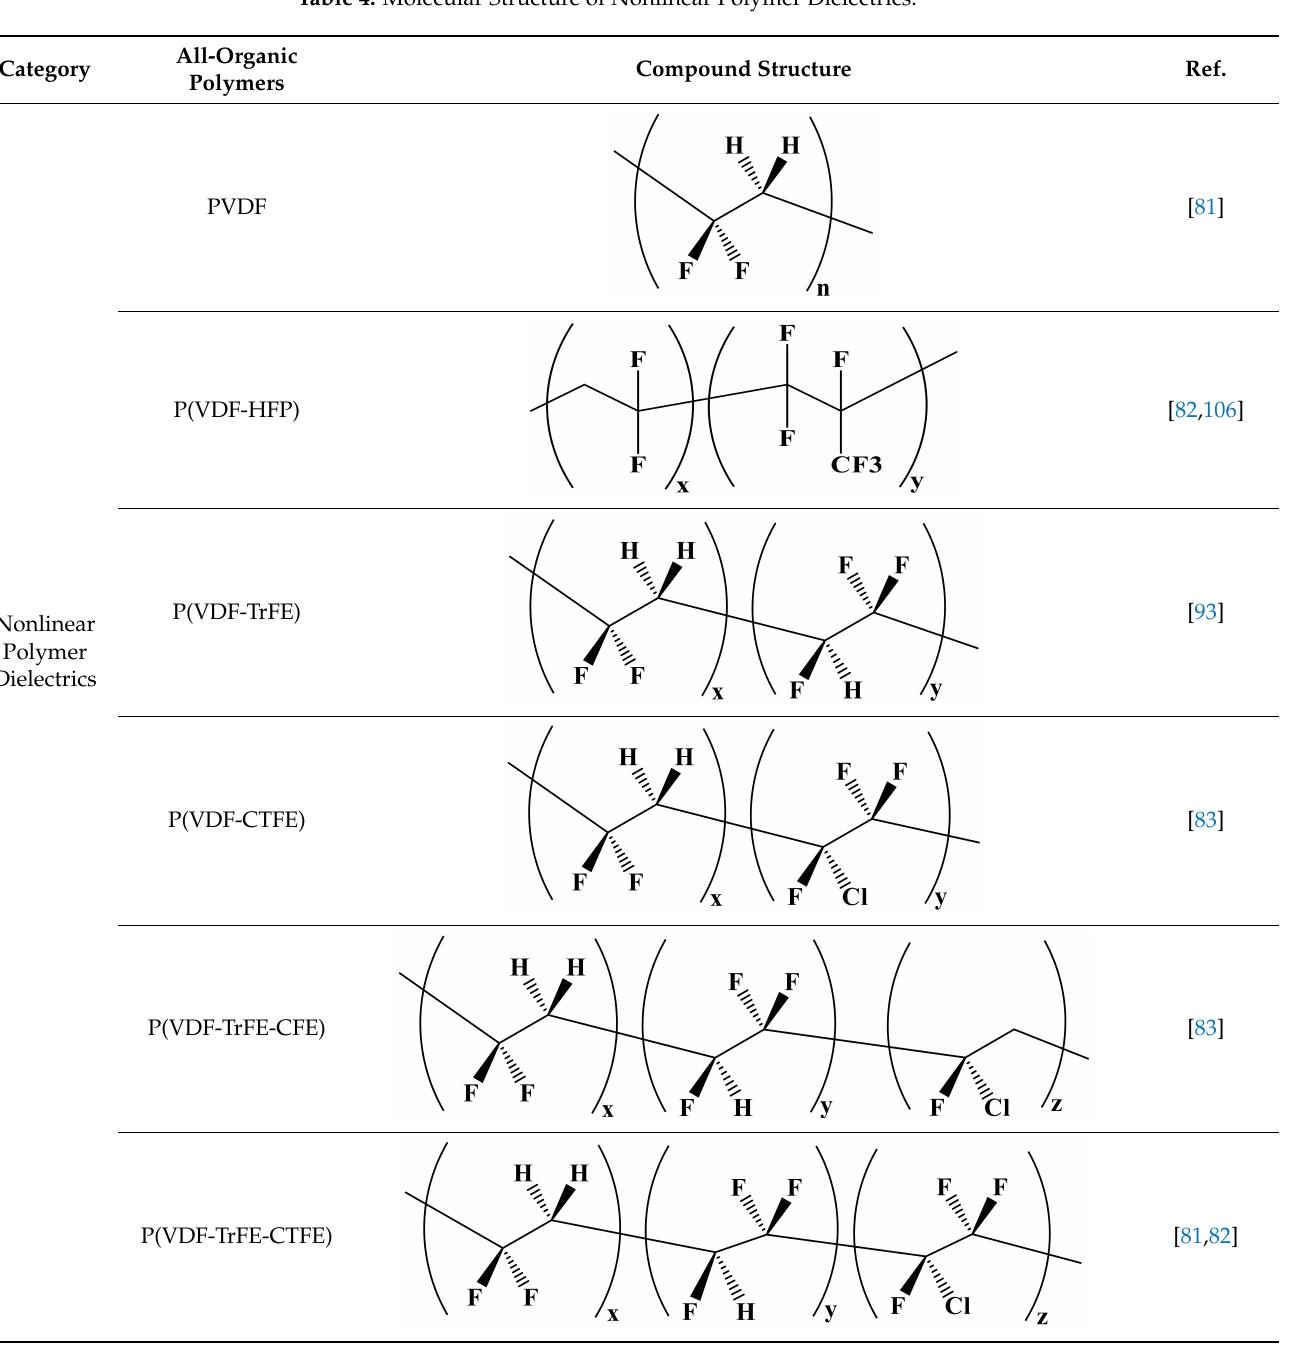
Table 4. Molecular Structure of Nonlinear Polymer